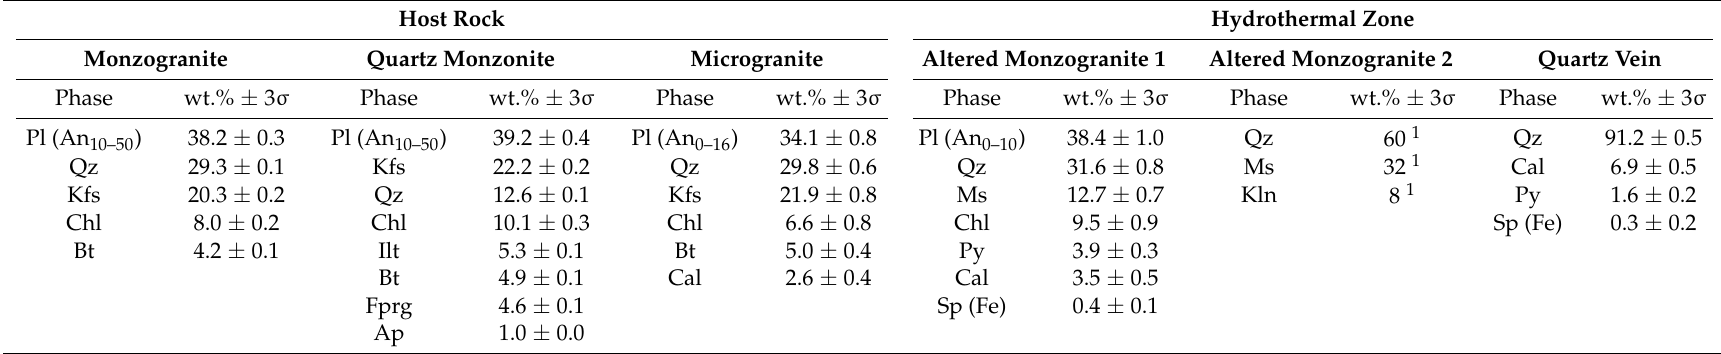
Table 6. X-ray diffraction results for samples from the NW part of the Naundorf quarry. Mineral abbreviations after